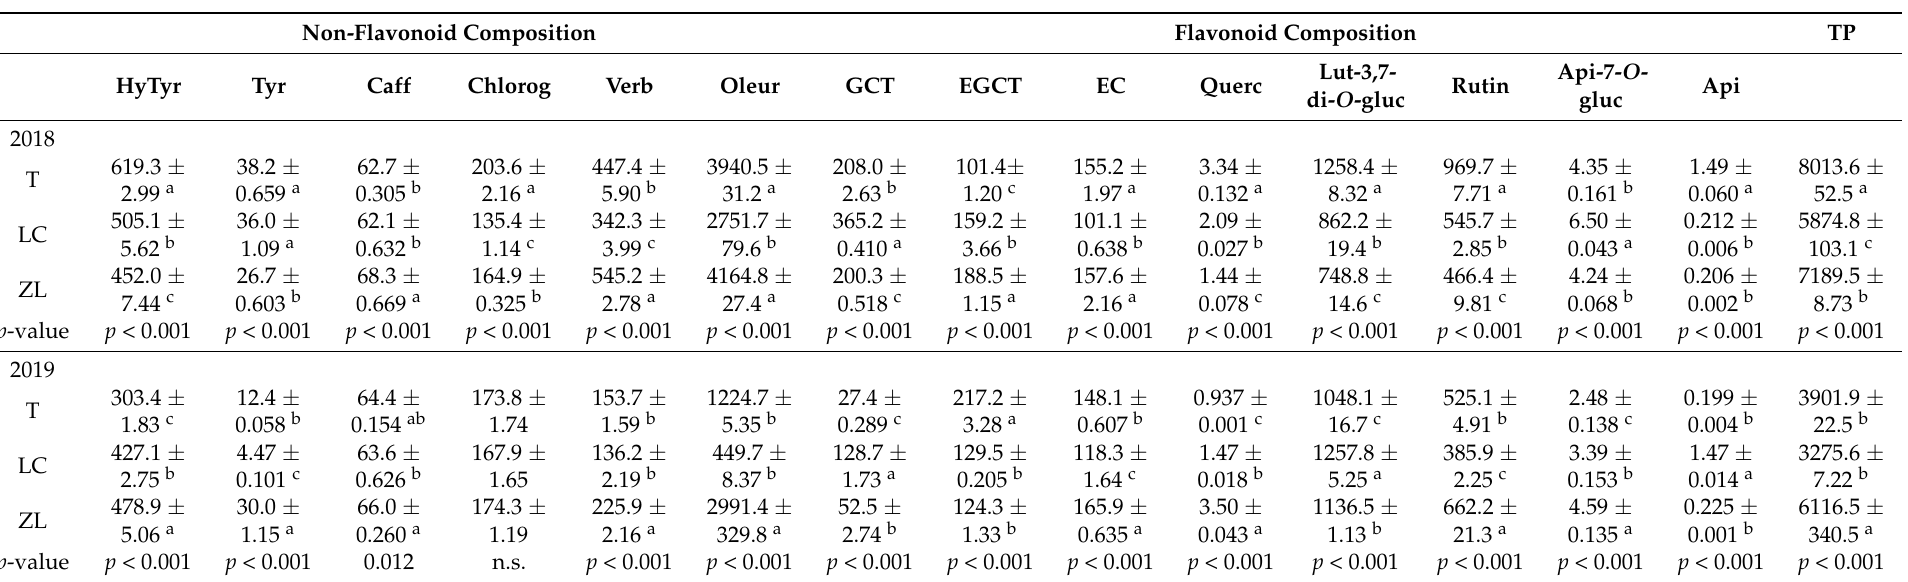
Table 5. Olive fruit polyphenolic composition as a function of soil management treatment and harvest year. Hydroxytyrosol (HyTyr), tyrosol (Tyr), caffeic acid (Caff), chlorogenic acid (Chlorog), verbascoside (Verb), oleuropein (Oleur), gallocatechin (GCT), epigallocatechin (EGCT), epicatechin (EC), quercetin-3,7-di- O